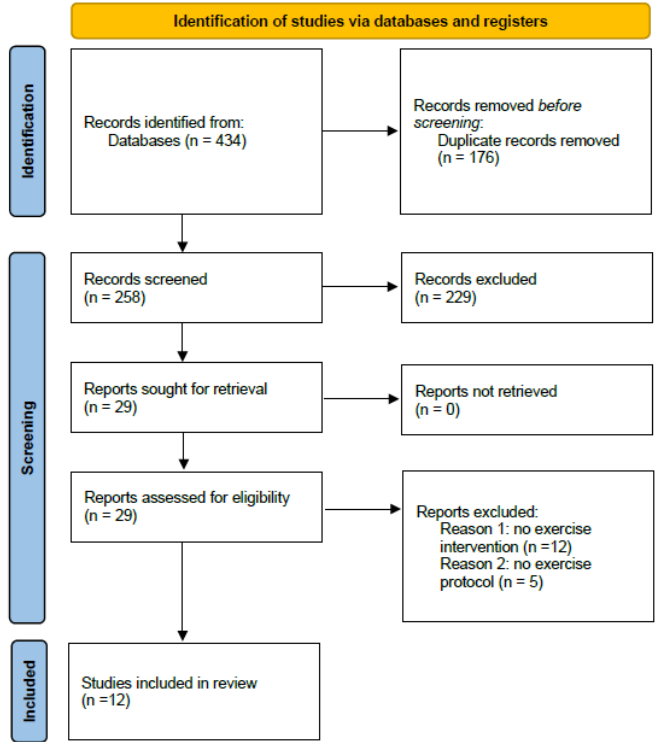
Figure 1. Flow diagram of the studies included.